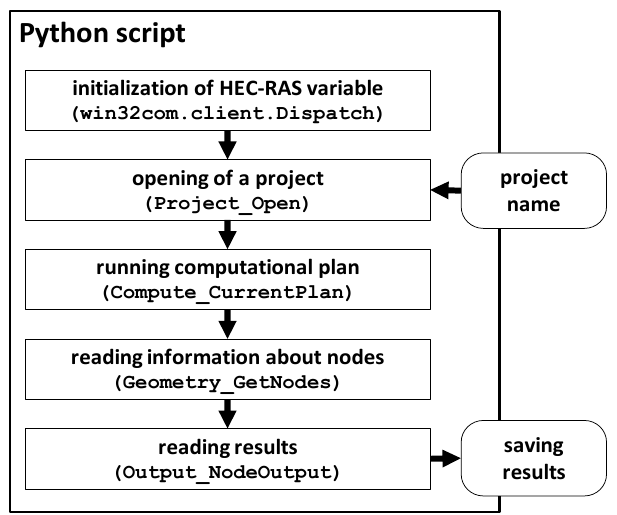
Figure 1. Main elements of computations in Example 1.